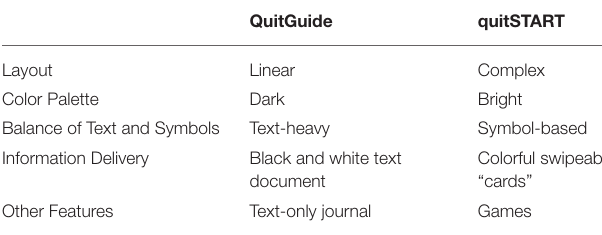
TABLE 1 | Comparison of QuitGuide and quitSTART characteristics. QuitGuide